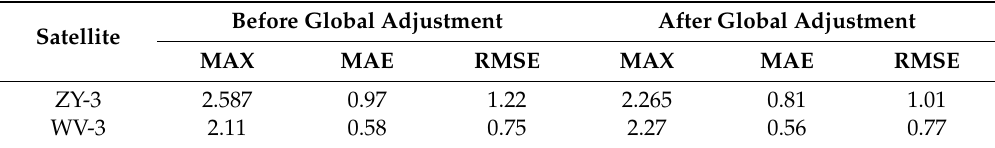
Table 4. Statistics of the differences between the estimated and measured water depths 1 (Unit: m) Before Global Adjustment After Global Adjustment Satellite MAX MAE RMSE MAX MAE RMSE